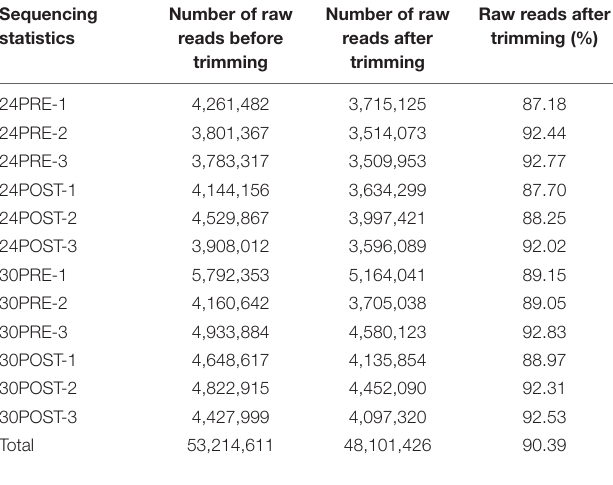
TABLE 1 | RNA-Seq reads obtained on Illumina MiSeq